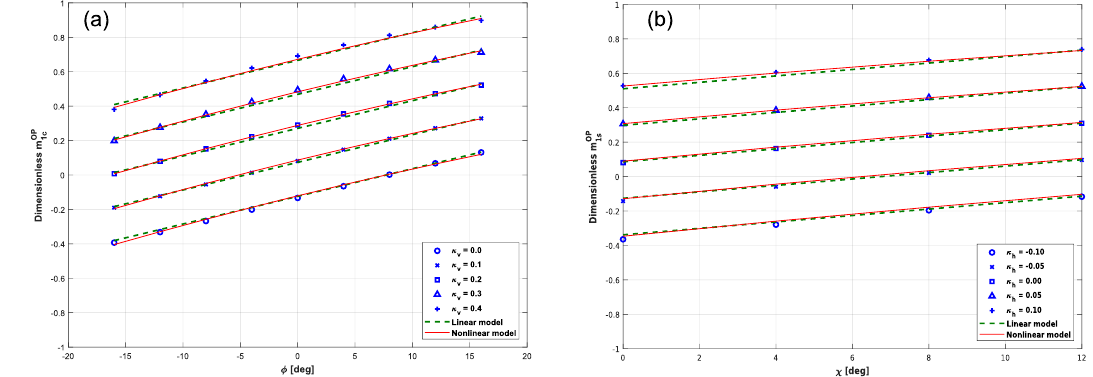
Figure 3. Comparison between measured and predicted harmonics for the linear model (dashed thick lines) and the nonlinear model of order 2 (solid thin lines). Normalized 1